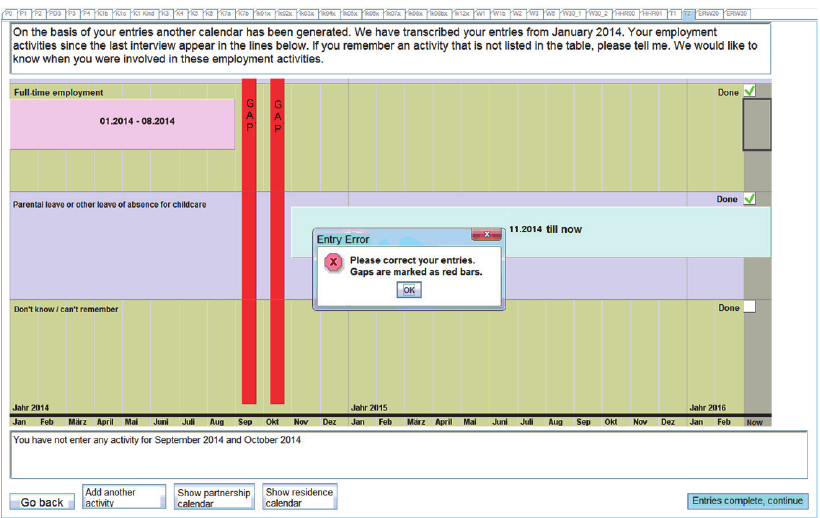
Figure 3 Activity calendar. The respondent entered no activity for two months, which are marked